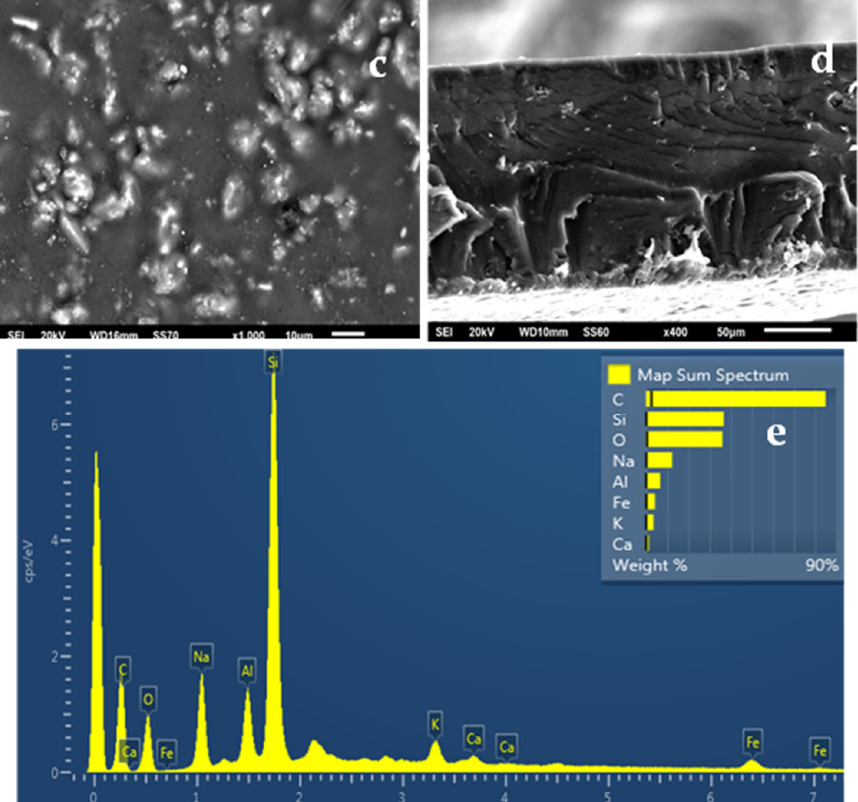
Figure 7. ( a , c ) SEM images of the surface and ( b , d ) cross-section for the nanocomposite films of ALG/G/5NZ ( a , b ) and ALG/G/5TO@NZ ( c , d ) respectively. ( e ) Energy dispersive spectrometer (EDS) spectrum and relative elemental analysis of the surface (inset) from the SEM image ( a ).